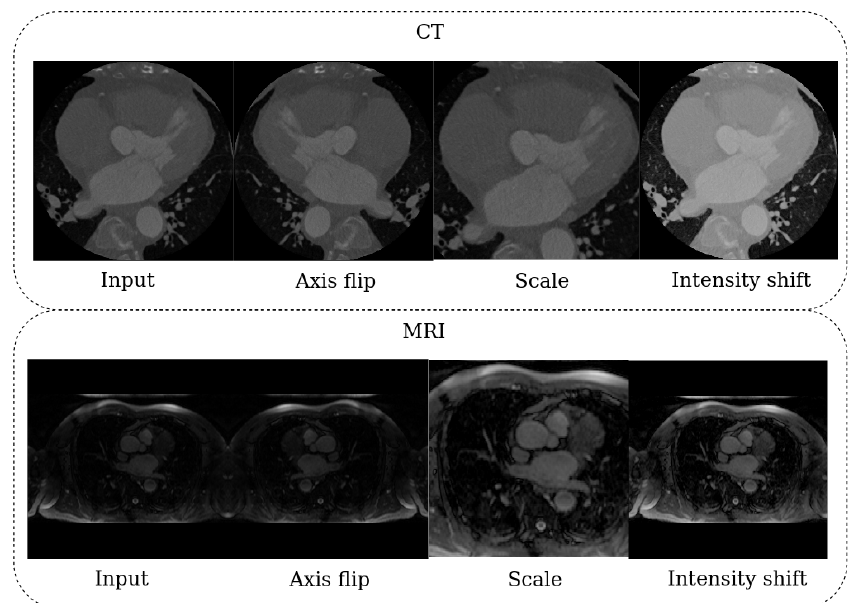
Figure 4. Examples of different augmentation methods on input CT and MRI